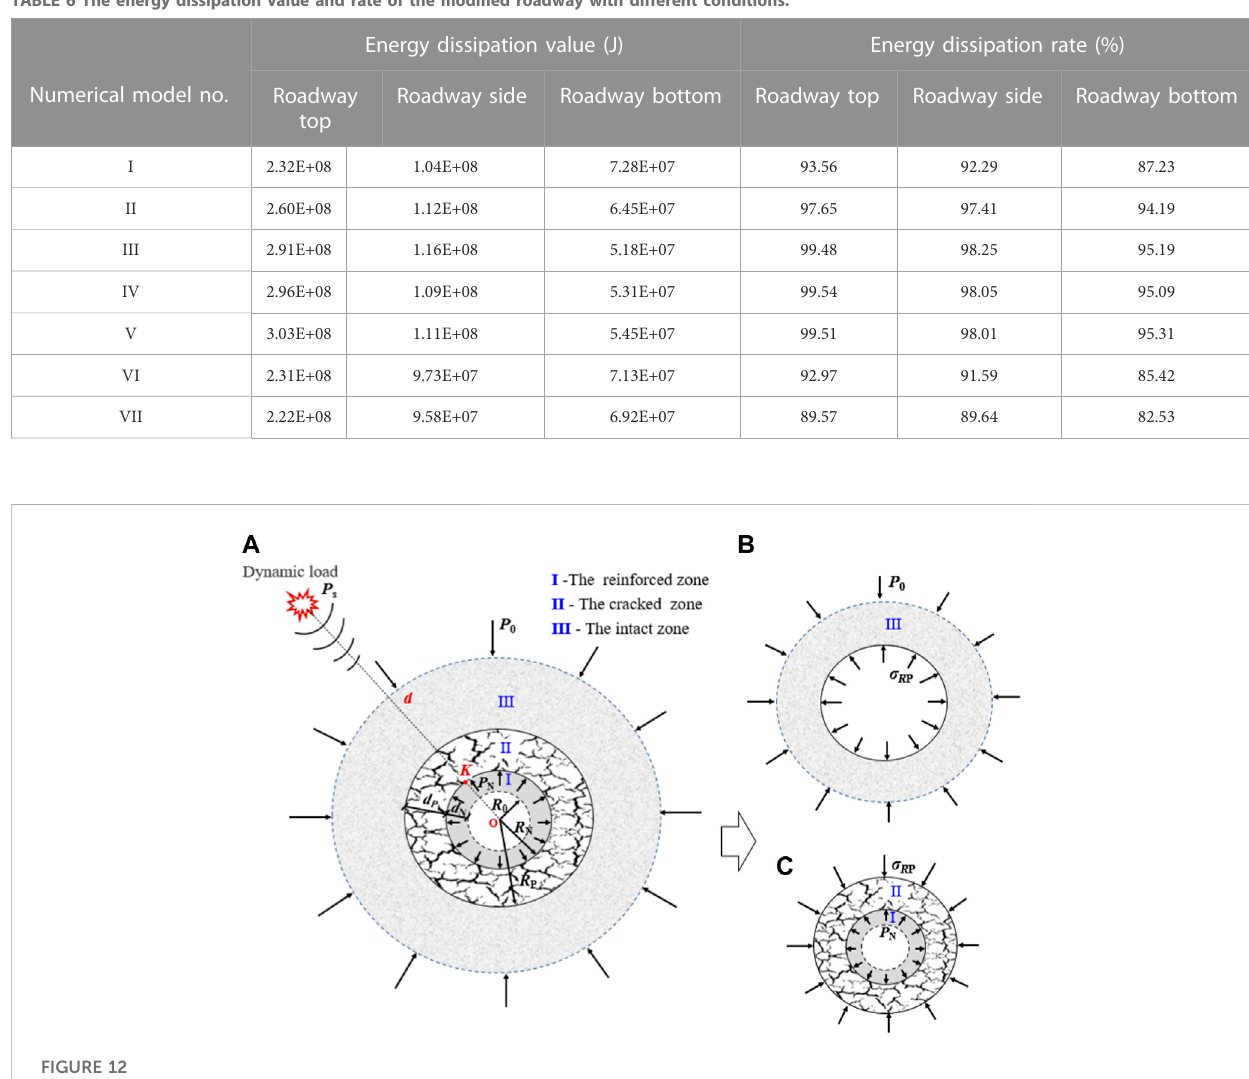
TABLE 6 The energy dissipation value and rate of the modi fi ed roadway with different conditions.